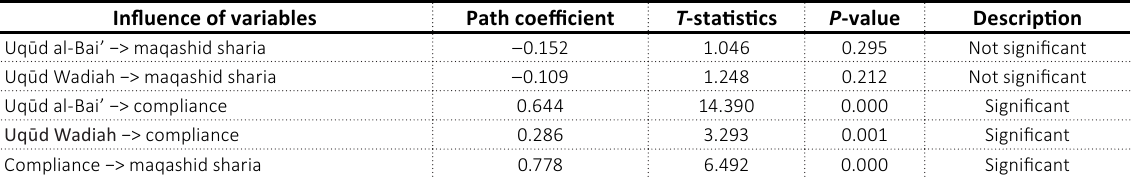
Table 2. Research results